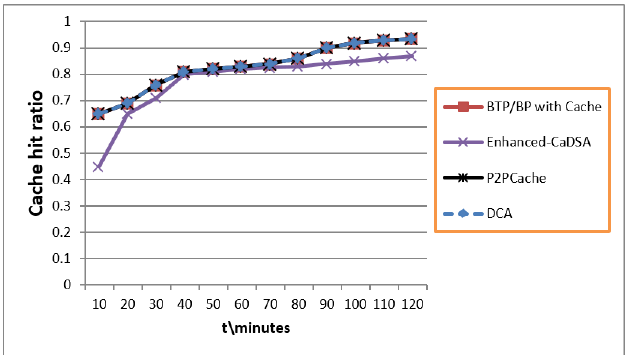
Figure 20. Cache Hit